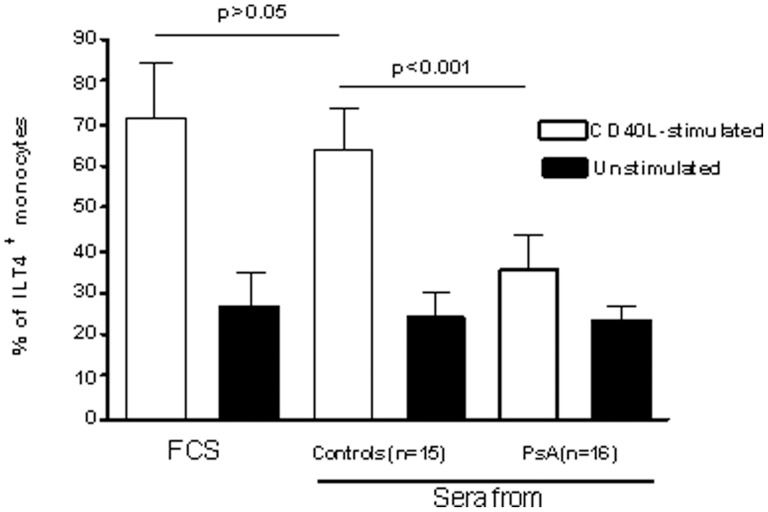
Sera from PsA patients downmodulate ILT4 expression in CD40L-stimulated, normal monocytes.Sera from each of the 16 patients with PsA and of the 15 controls were incubated with elutriated monocytes from a single healthy donor. Sera from patients and controls were obtained at baseline. Medications of patients at baseline are reported in Table 1. FCS was used as negative control. The experiments were performed twice, using cells from two different healthy donors; each experiment was carried out in triplicate wells. The data represent mean±SD (error bars). Comparison between means was performed by Student's unpaired t test. MFI values of ILT4 expression in CD40L-stimulated and, in parenthesis, unstimulated cells were as follows: FCS-exposed, 145±13.9 (34.5±12.4); normal serum-exposed, 120.3±11.2 (30.9±13.7); patient's serum-exposed 33.6±8.4 (36.1±14.6). CD40L: FCS-exposed vs. normal serum-exposed, P>0.05; normal serum-exposed vs. patient's serum-exposed, P<0.001. Unstimulated: FCS-exposed vs. normal serum-exposed, and normal serum-exposed vs. patient's serum-exposed, P>0.05.